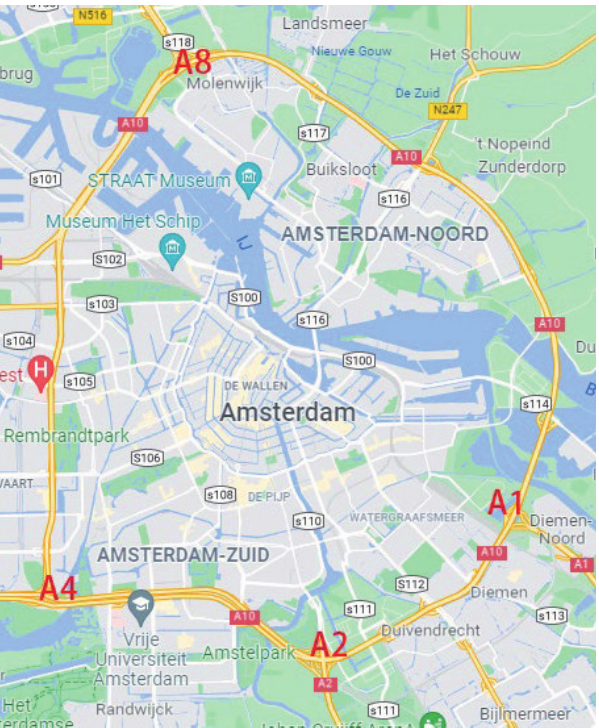
Figure 3. The four intersections of the Amsterdam A10 ring road that access the ring road, named A1, A2, A4, and A8. Sensors are embedded in the RSU and placed at each